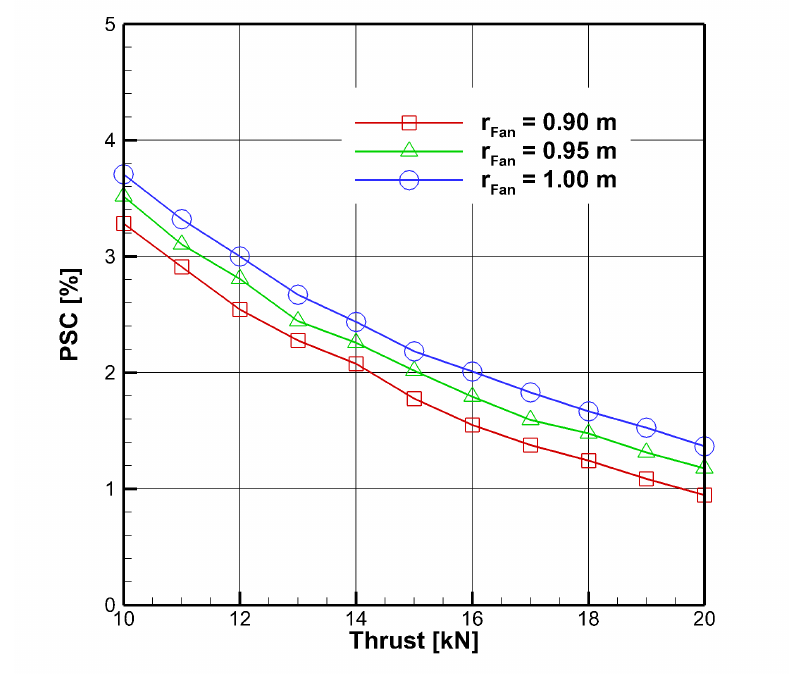
Figure 12. PSC for different engine sizes, H =